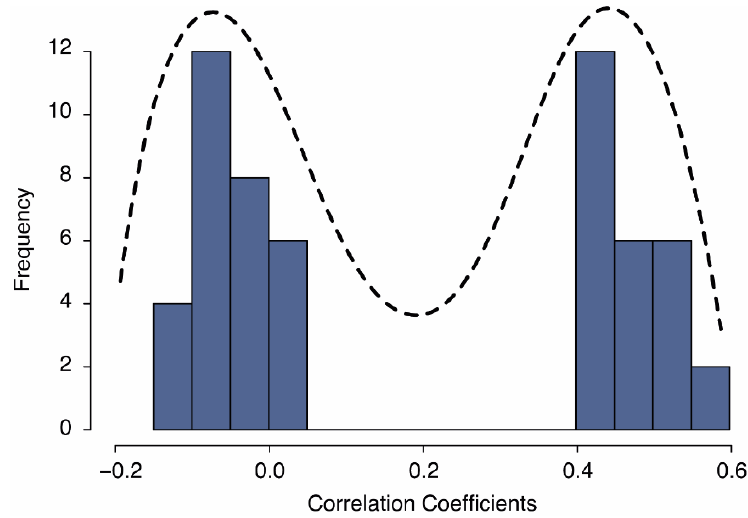
Figure 1. The bi-modal inter-item correlation frequency distribution for the two-dimensional PAQ-8. Figure 1. The bi ‐ modal inter ‐ item correlation frequency distribution for the two ‐ dimensional PAQ ‐ 8. Table 4. Goodness-of-fit indices for the Exploratory Factor Analyses (Analysis 1). Table 4. Goodness ‐ of ‐ fit indices for the Exploratory Factor Analyses (Analysis 1). TLI RSMEA RMSR BIC PAQ-9 0.95 0.061 0.033 − 64.20 TLI RSMEA RMSR BIC PAQ-8 0.97 0.051 0.025 − PAQ ‐ 9 0.95 − 51.07